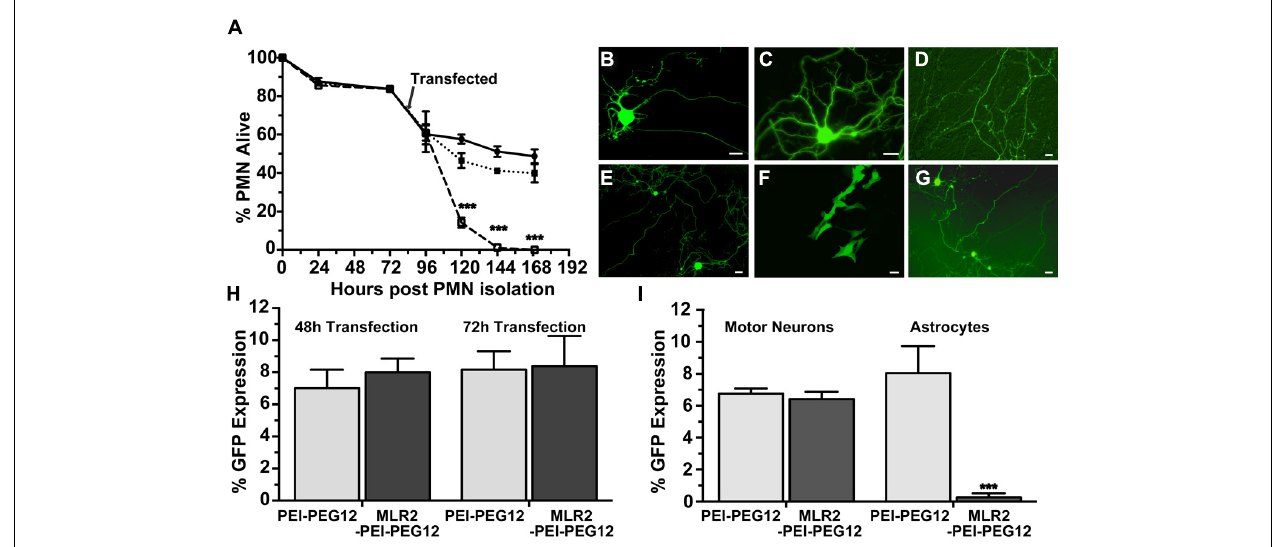
FIGURE 4 |Transfection of mouse primary motor neurons (PMN) with plasmid DNA using targeted nanoconstructs. (A) PMN were isolated from E12.5 embryos and transfected 3 days later with pGwiZ carried by MLR2-PEI (open squares) or MLR2-PEI-PEG12 (closed squares). The number of alive and dead motor neurons for each treatment or no treatment (closed circles) were counted every 24 h and the % of neurons that were alive calculated from the original 3000 neurons plated per well in 48-well plates ( n = 5). There was significantly ( ∗∗∗ p < 0.001) less PMN alive after treatment with MLR2-PEI-pGwiZ. (B) Green fluorescent protein (GFP) expression in live pure motor neurons 48 h after transfection with by MLR2-PEI-PEG12-pVIVO2. (C,D) GFP expression after